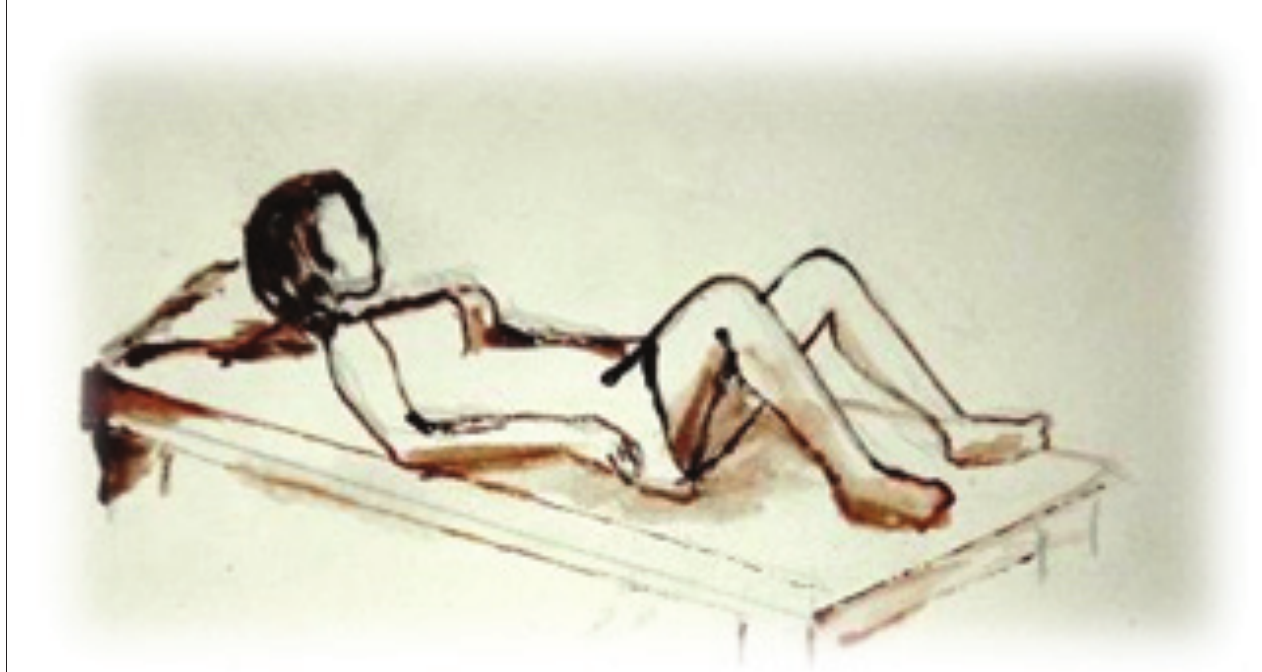
FIGURE 1: Lithotomy